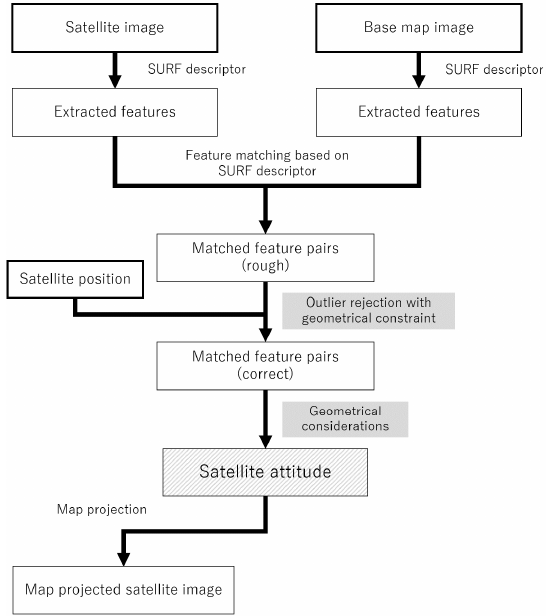
Figure 2. Overview of the proposed method for satellite attitude determination and map